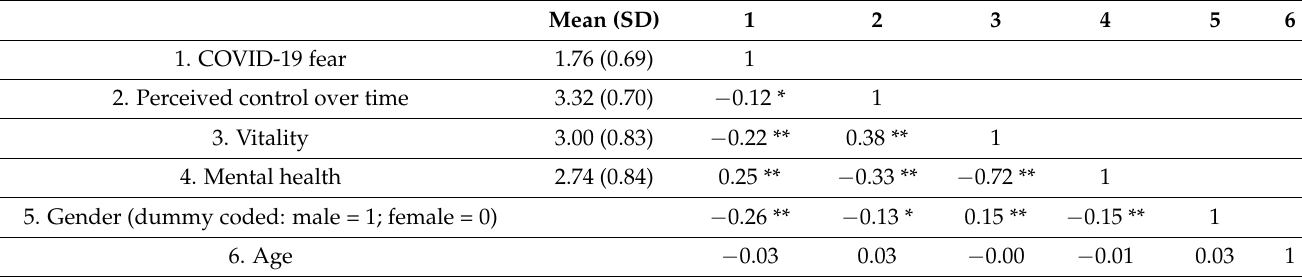
Table 1. Descriptive statistics and zero-order correlation